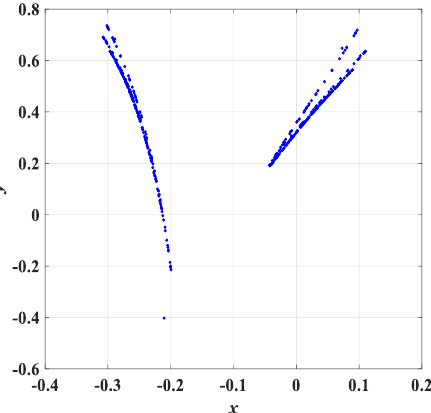
Figure 8. Poincaré map in the x ‐ y ‐ z space with the cross ‐ section z 0 = − 0.1.